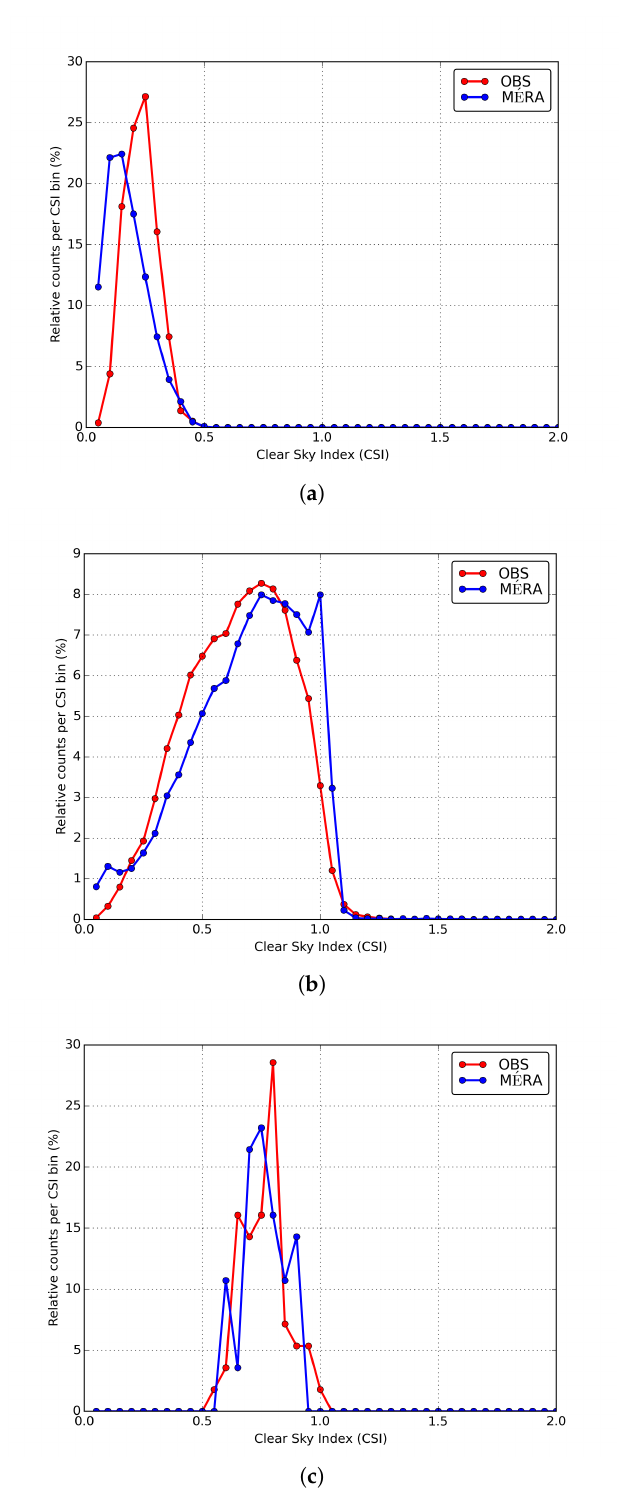
Figure 14. Frequency distributions for MÉRA of daily weighted CSI for the following variability